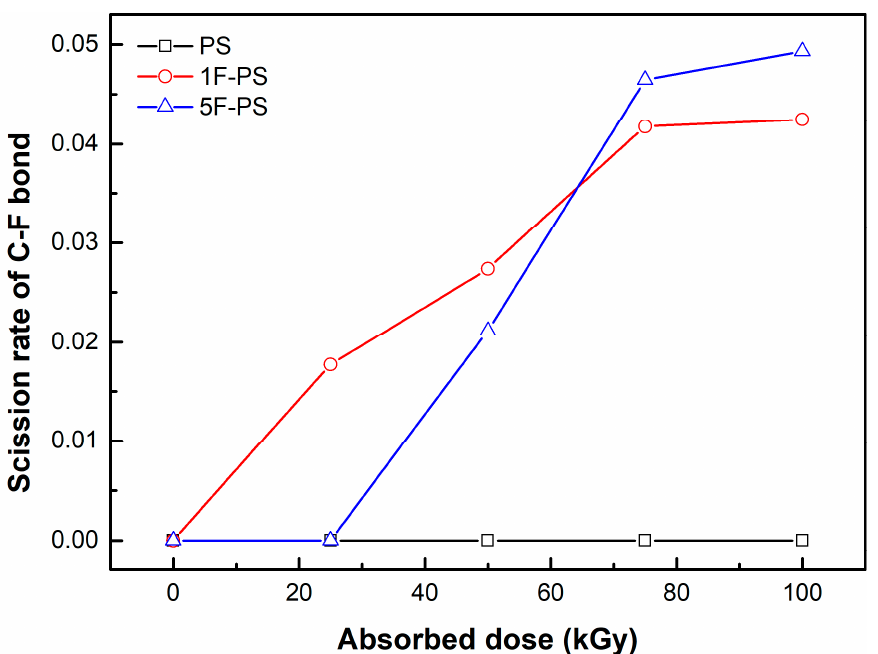
1F-PS and 75 to 100 kGy for 5F-PS. The increment of the scission rate was decreased after 50 kGy for polystyrene and 75 kGy for 1F-PS, 5F-PS. Figure 12. Scission rate of C-H bond of polymers. Figure 12. Scission rate of C-H bond of polymers.